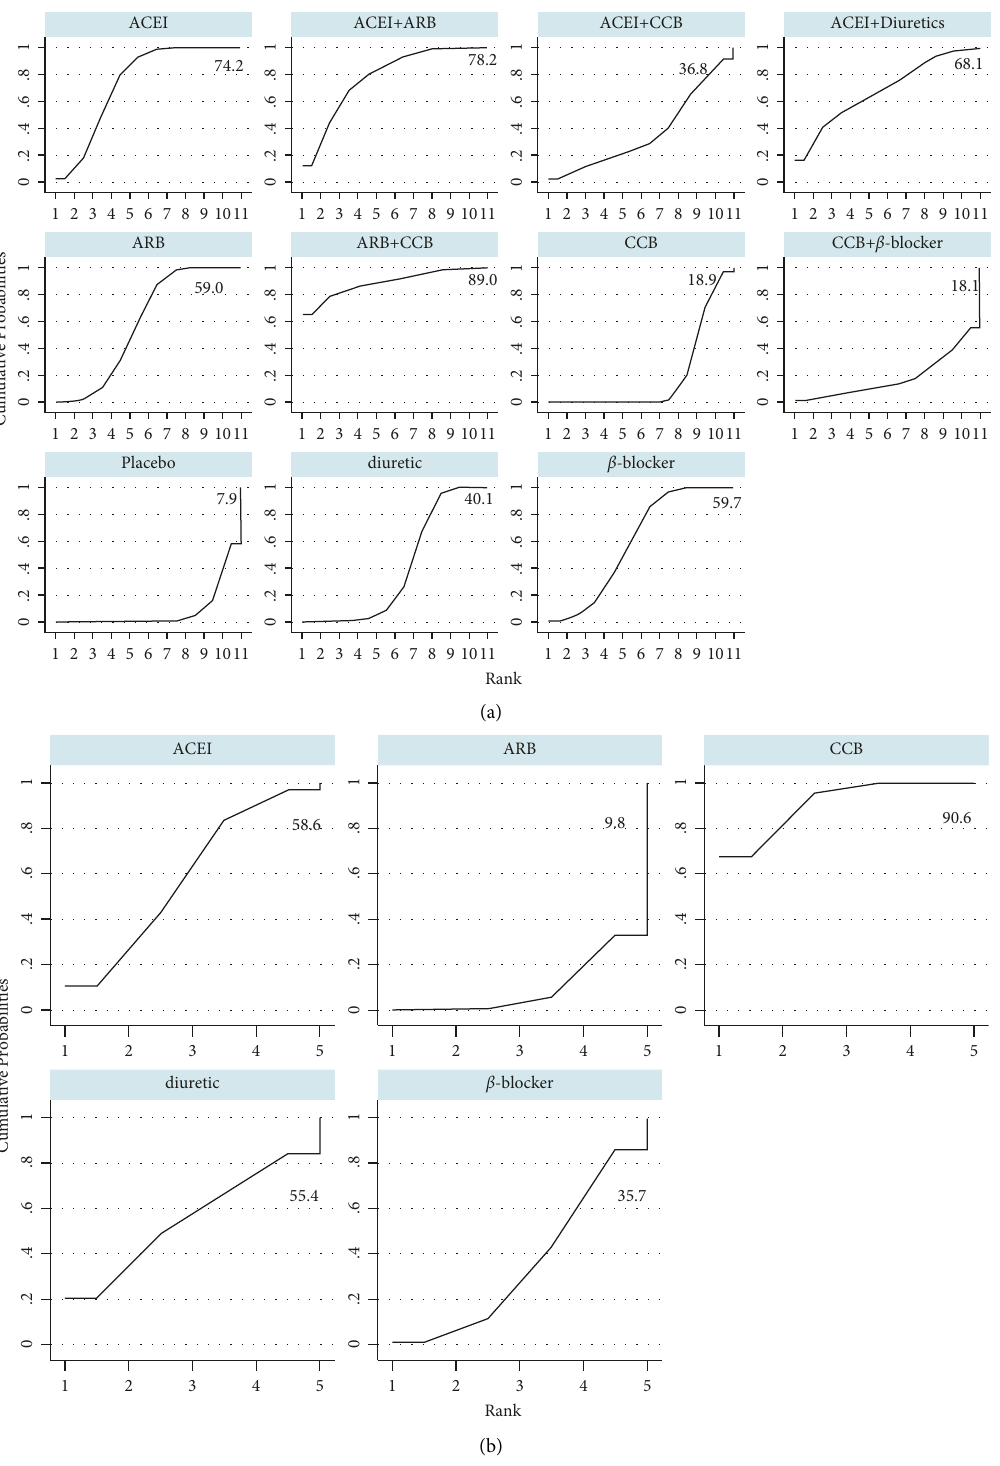
Figure 8: Mean ranking plots. (a) Flow-mediated dilation, (b) brachial artery diameter). ACEI: angiotensin-converting enzyme inhibitors, ARB: angiotensin receptor blocker, CCB: calcium channel